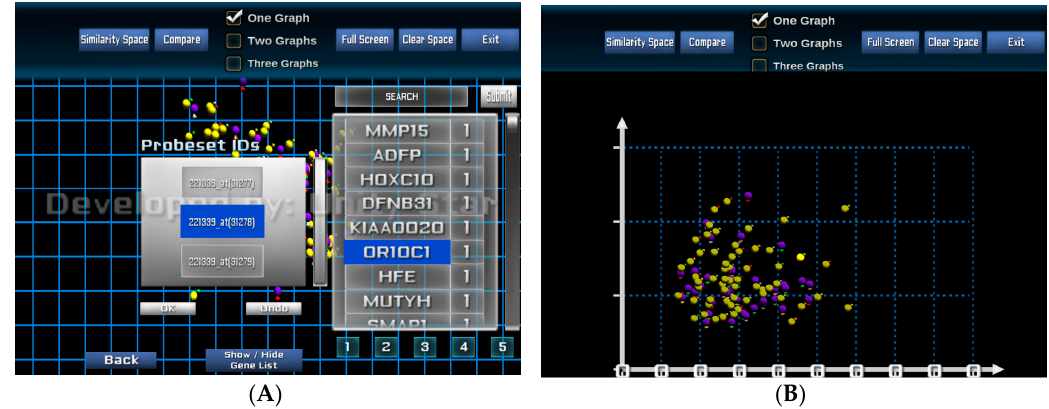
Figure 5. Gene selection for ( A ) the selection interface and ( B ) re-arrangement of the similarity space of the patient cohort based on the selected genes and probe sets.